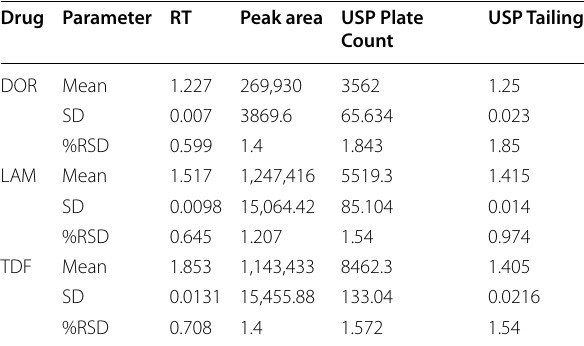
Table 2 System suitability results of DOR, LAM and